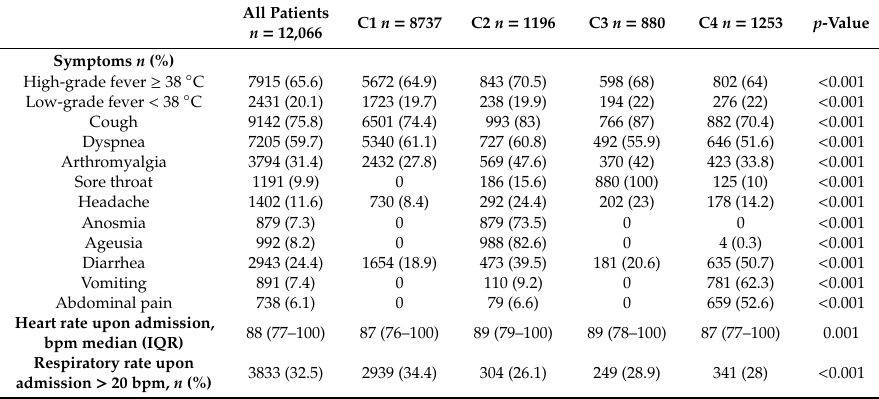
Table 2. Symptoms and physical examination between